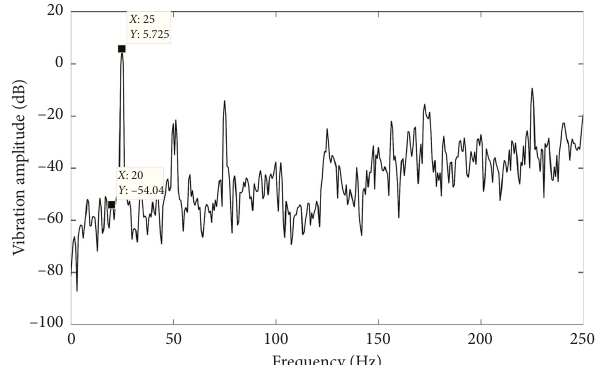
Figure 10: Spectrum at the vibration input end of the truss frame.